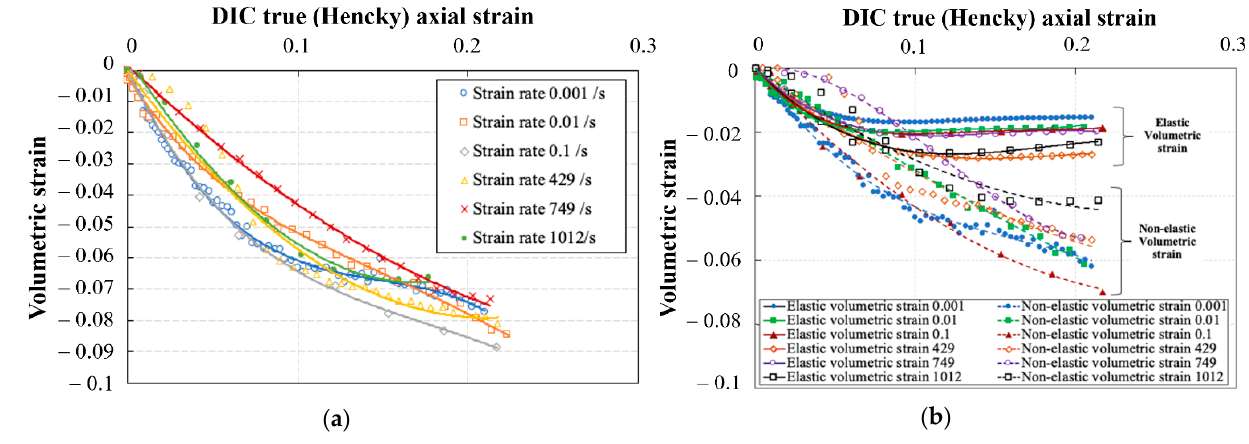
Figure 13. Variation of the relative volume change on the neat epoxy resin as a function of true axial strains at different strain rates during compression: ( a ) volumetric strain, ( b ) elastic and non-elastic volumetric strain.